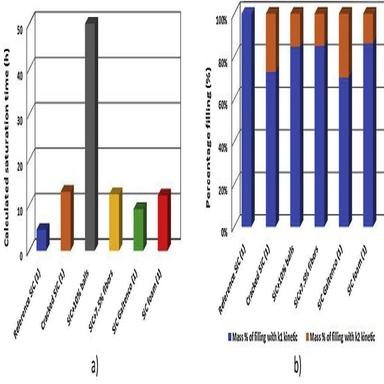
Extrapolations for the six main samples: a) estimated saturation times and b) estimated ratio of the filled volumes with k Hex 1 and k Hex 2 kinetics.